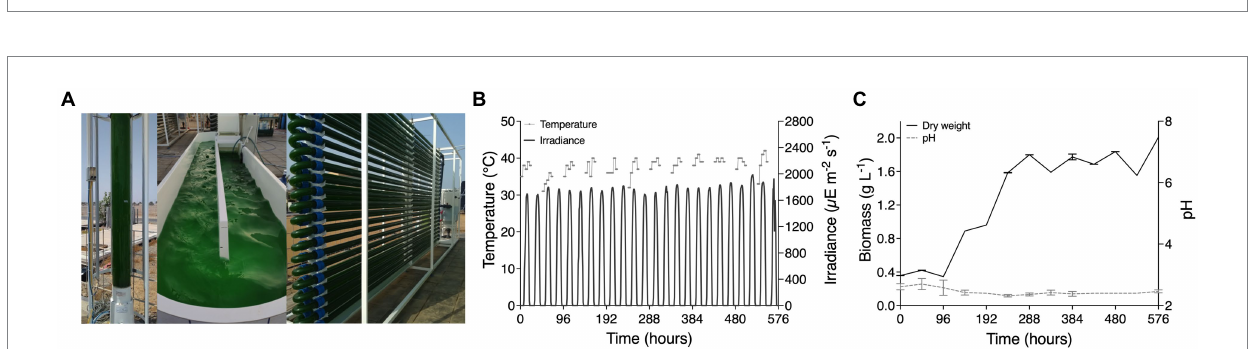
FIGURE 2 Scaled cultivation of C. merolae 10D in various culture set-ups in Thuwal, Saudi Arabia in July and August 2022. (A) Cultures in a 60 L column photobioreactor were used as inoculum for a 600 L raceway pond, which was consequently used to inoculate a 1 m 3 tubular photobioreactor (picture left). (B) Daily irradiance at the tubular reactor and temperature, every other day, for 576 h during cultivation (middle). (C) Culture performance was measured by cell dry weight throughout the cultivation and pH was also recorded